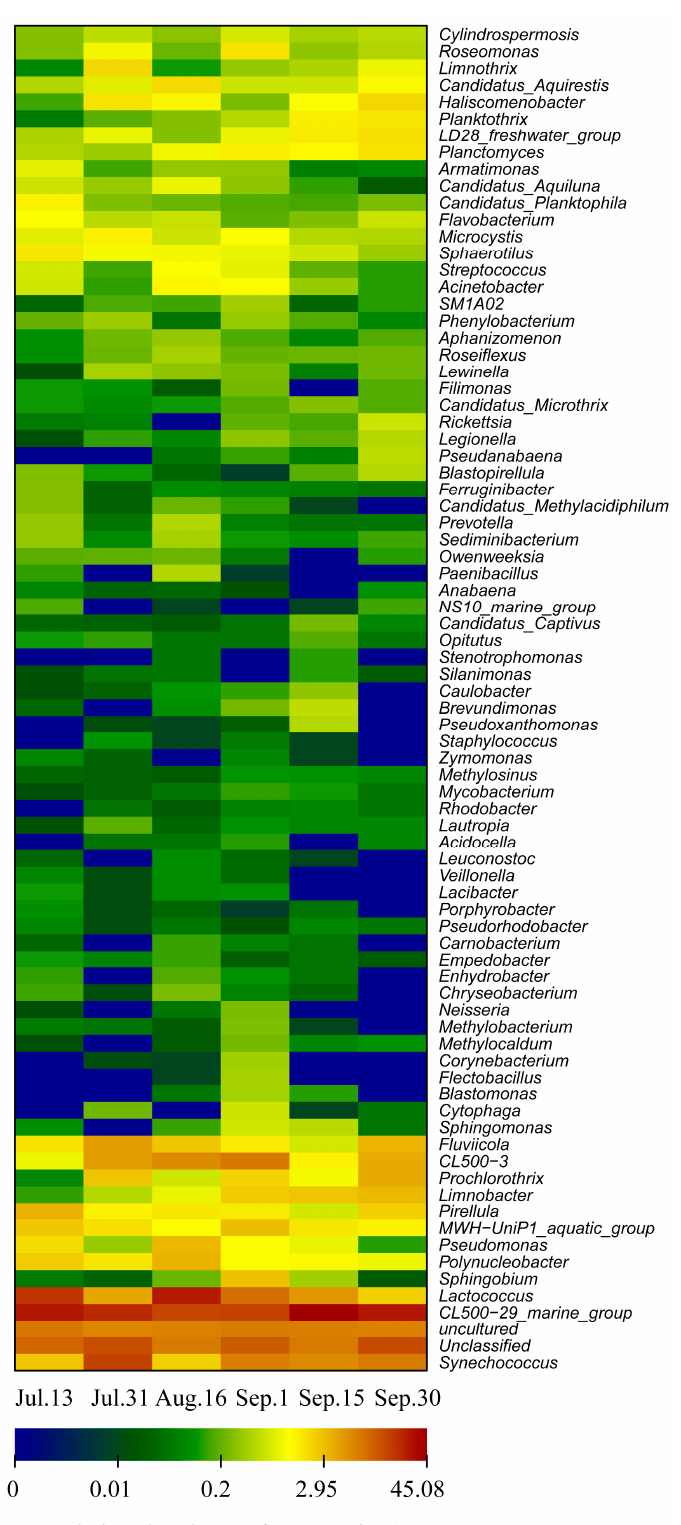
Figure 6. Heat map showing 80 representative predominant 16S rRNA gene based sequence classified at the genus level in Zhoucun drinking water reservoir during algal bloom outbreak and decline from July to September, 2012. Blue colors indicate lower abundance, and red colors indicate higher abundance.